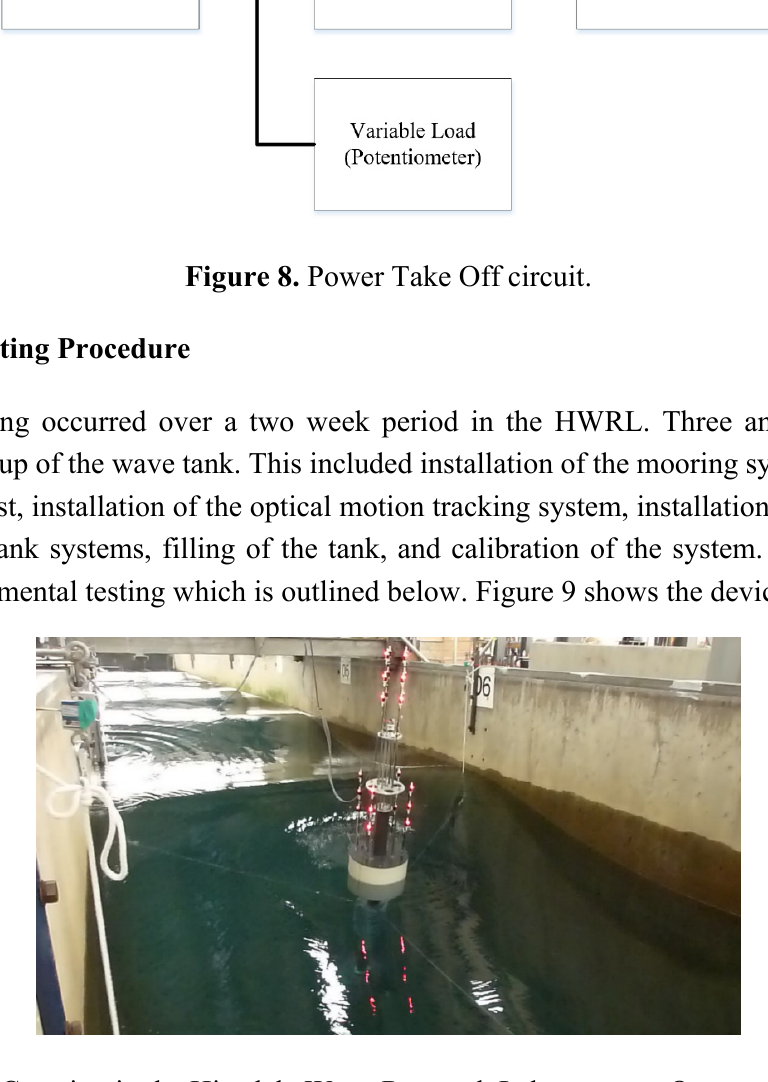
Figure 9. AWEC testing in the Hinsdale Wave Research Laboratory at Oregon State